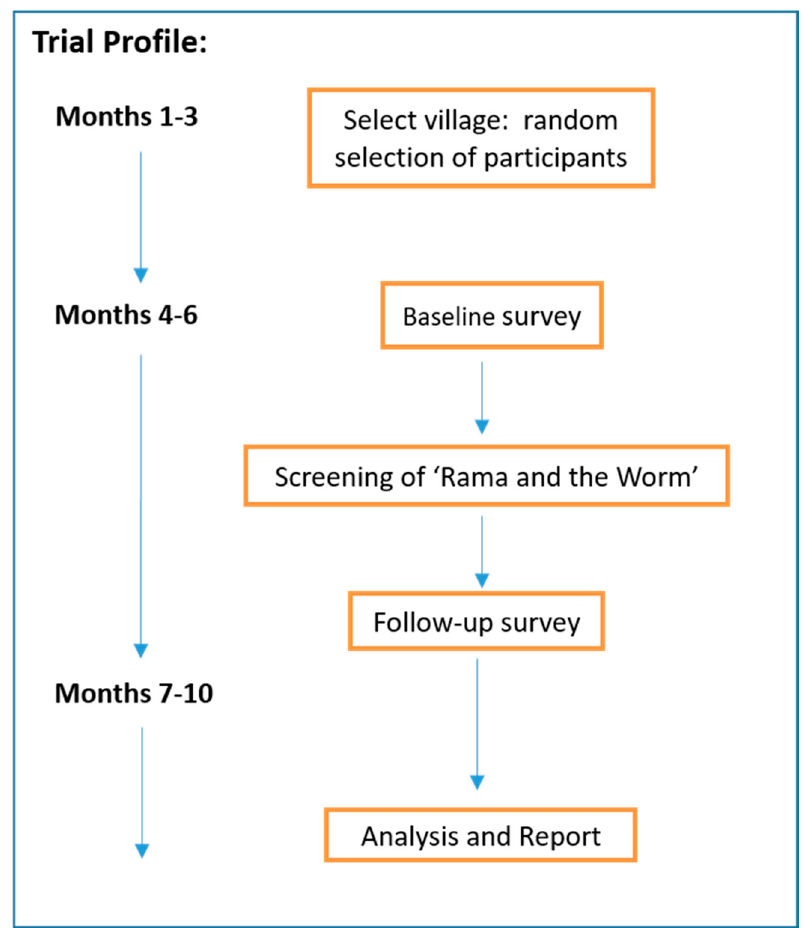
Figure 1. Flow chart of the Rama and the Worm study.